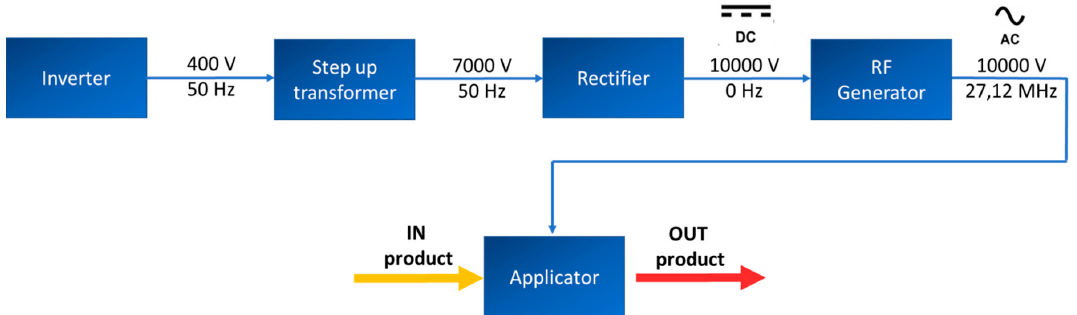
Figure 1. Schematic representation of an RF system.